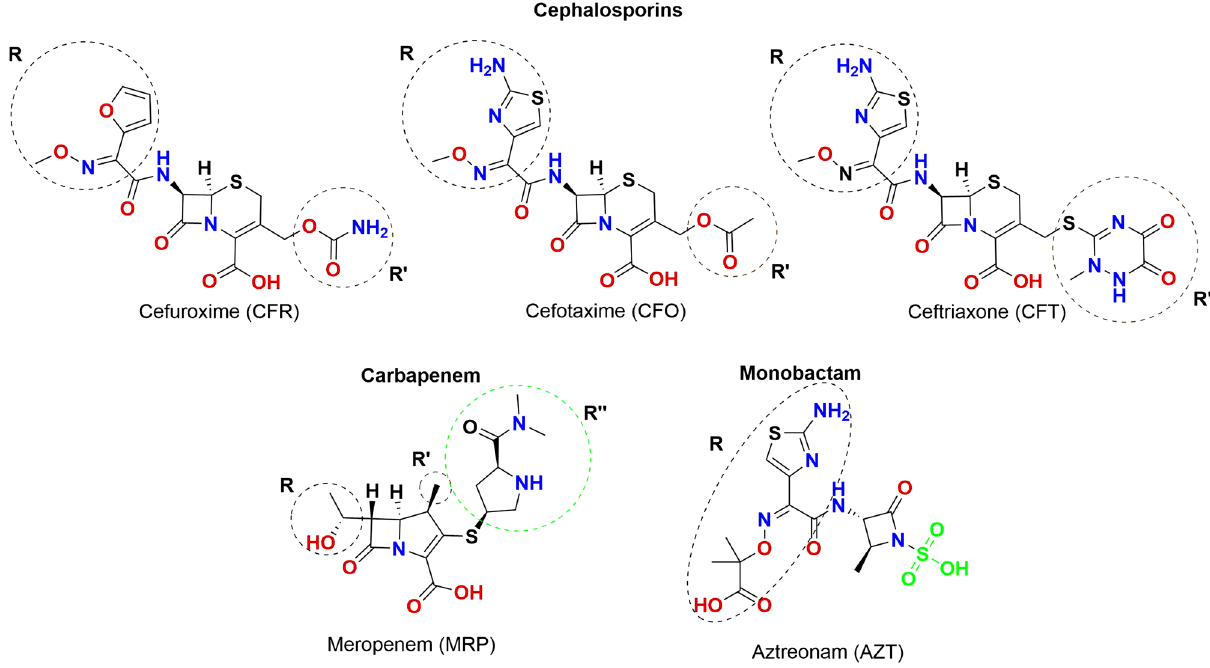
Figure 1. Chemical structures of the studied β-lactam antibiotics. ChemDraw Professional, Version 17.0.0.206 (121) https ://www.perki nelme r.com/es/produ ct/chemd raw-profe ssion al-chemd rawpr o.